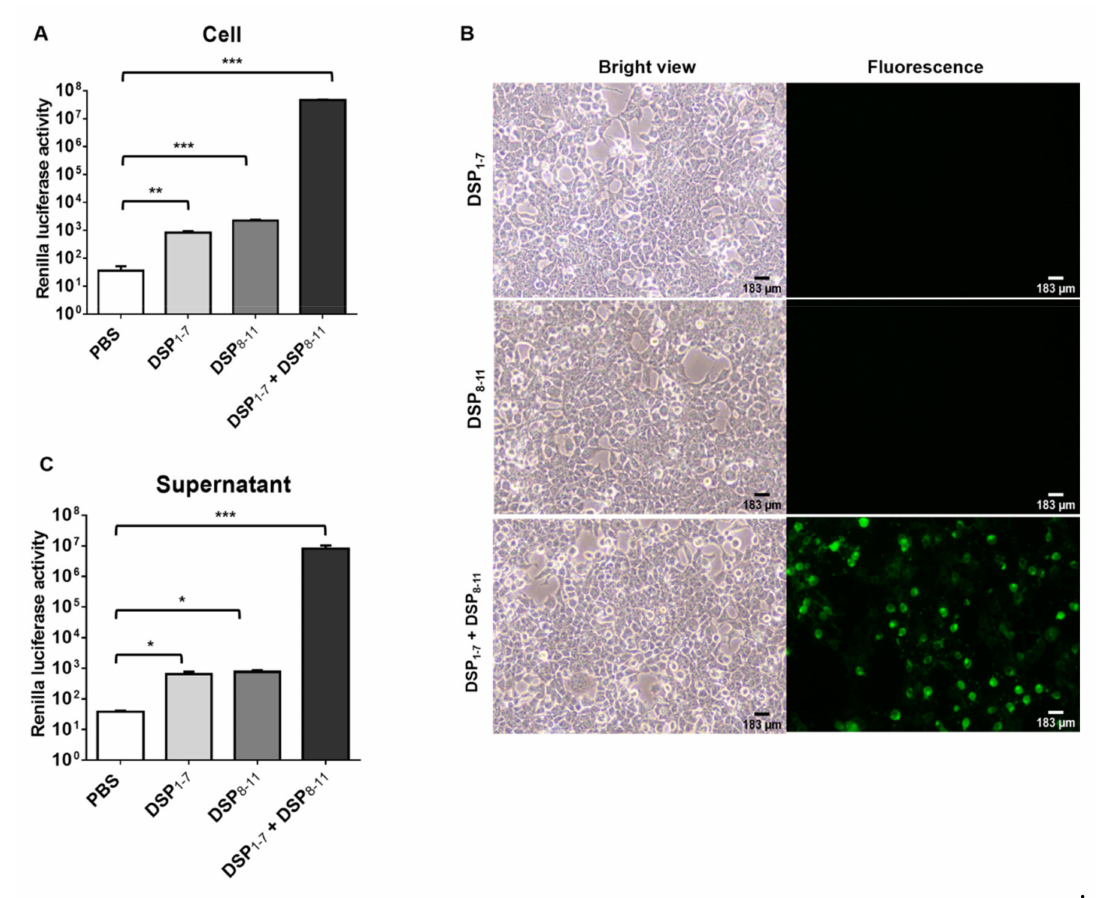
Figure 1. Generation and validation of nanoparticles expressing DSPs. ( A , B ) HEK293T cells were transfected with indicated plasmids. DSP expression was analyzed by measuring RL activity ( A ) and visualizing GFP expression ( B ). ( C ) Nanoparticles expressing DSPs were generated in HEK293T cells and analyzed by measuring RL activity. Error bars present SD from the mean ( n = 3). Statistical significance was assessed by Student’s t test. *, p < 0.05; **, p < 0.01; ***, p <